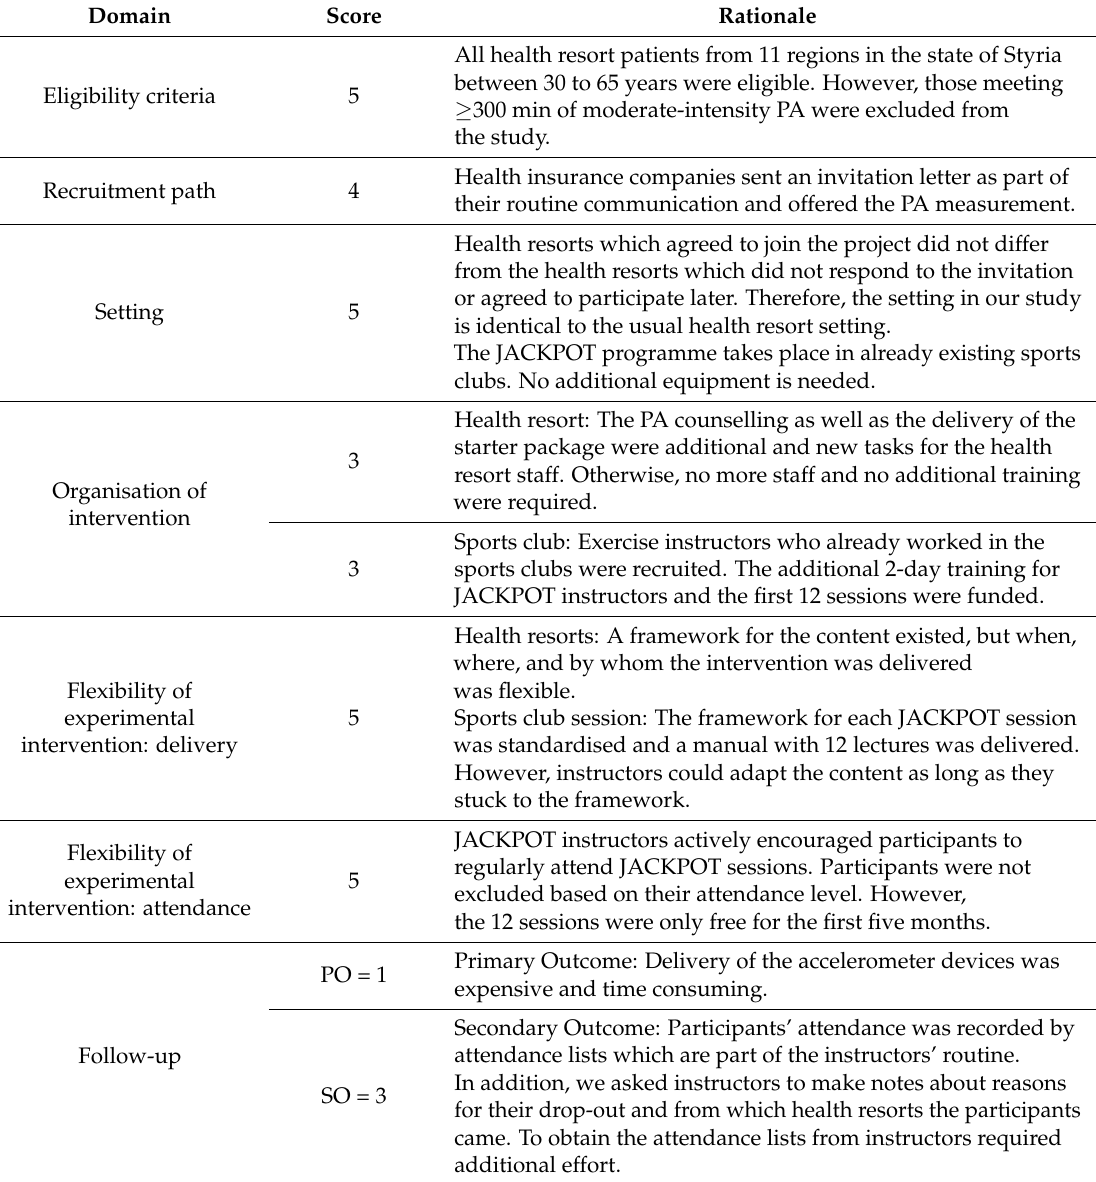
Table 4. PRECIS-2 scores, as rated by five members of the research